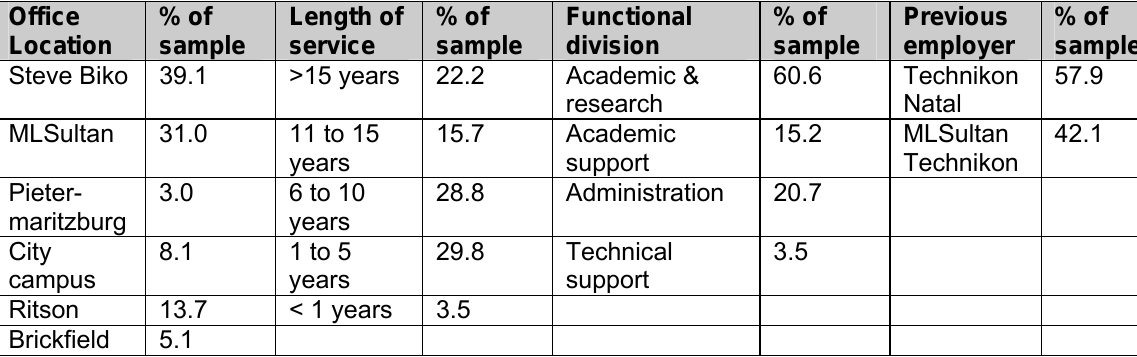
Table 1: Descriptive statistics of sample